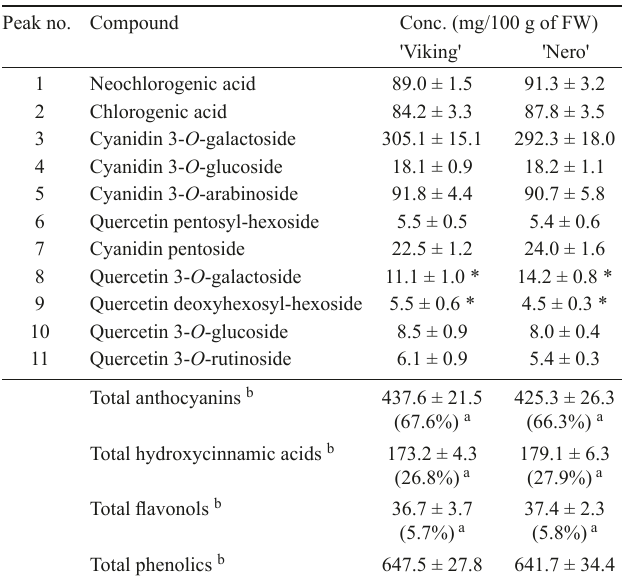
Tab. 4: Quantitation of individual phenolic compounds from black choke- berry cvs. 'Viking' and 'Nero' as determined by HPLC-DAD. Peak no.